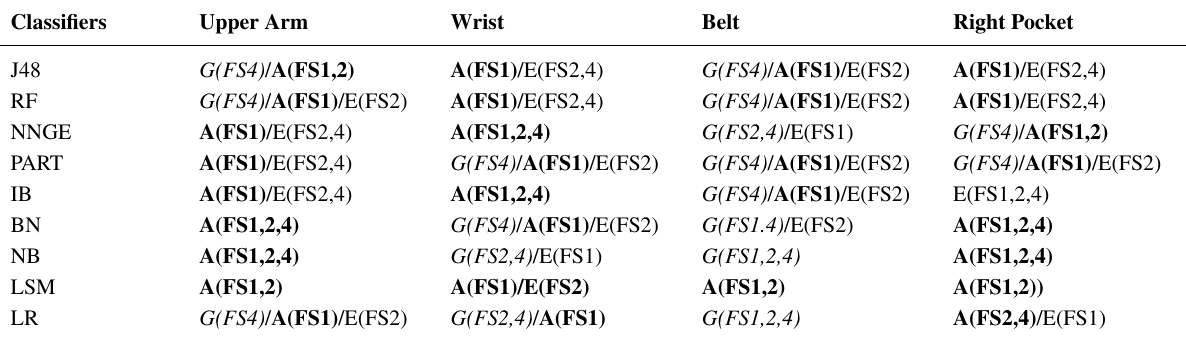
Table 7. Leading role: Accelerometer vs . gyroscope for the walking